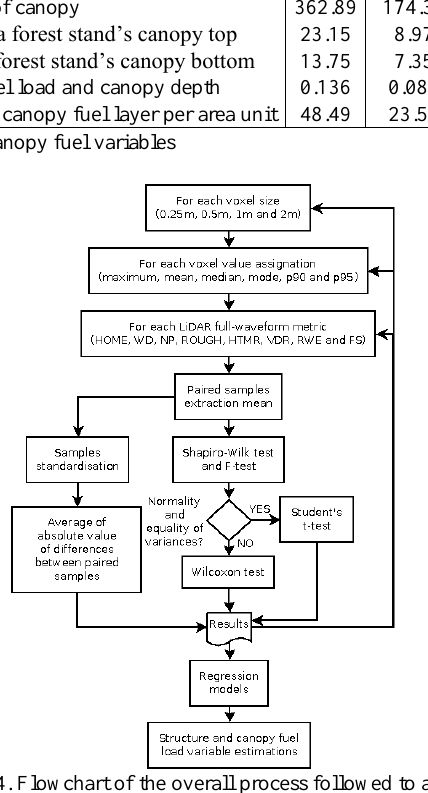
Figure 4. Flowchart of the overall process followed to assess and quantify dissimilarities between pairwise